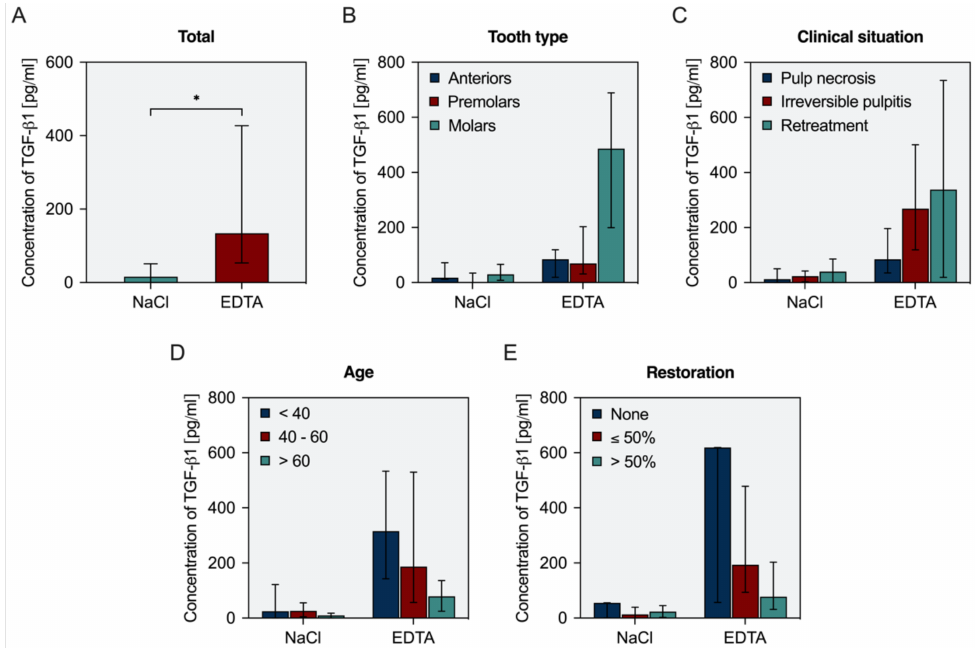
Figure 4. Release of TGF- β 1 into EDTA and saline for all 38 teeth ( A ) and according to tooth type ( B ), clinical situation ( C ), patient age ( D ) and extent of the coronal restoration ( E ). Depicted are median values with 25–75% percentiles. Asterisks indicate statistical differences between